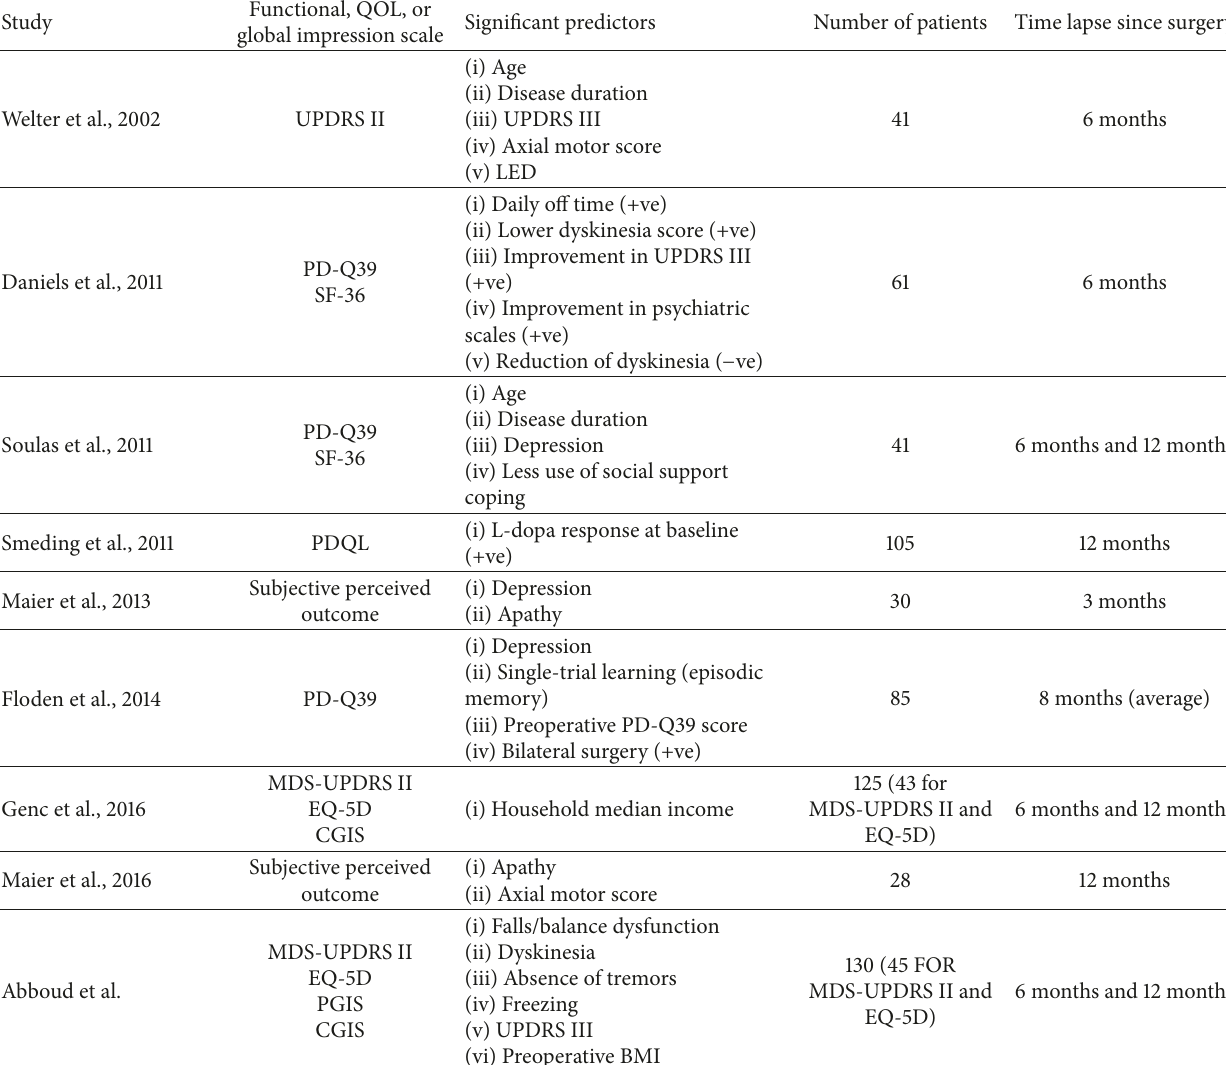
Table 3: Studies of functional, QOL, and global impression outcomes after DBS in